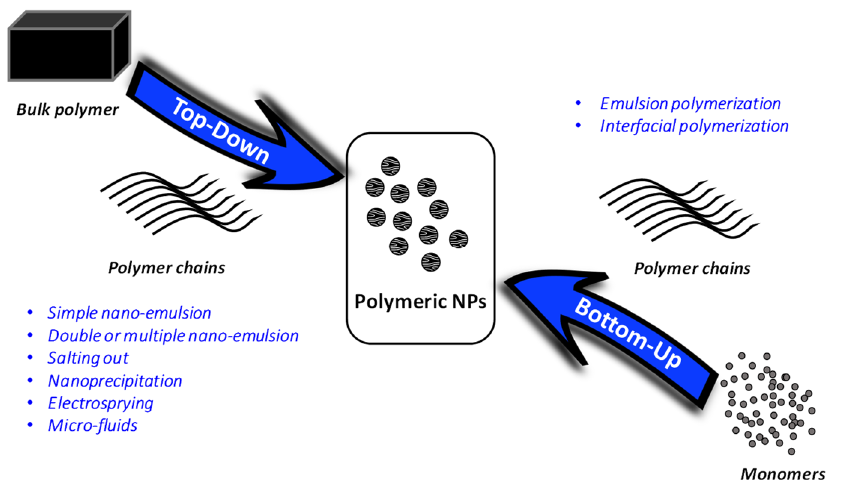
Figure 6. The methods to formulate polymeric NPs are divided into top-down and bottom-up methodologies. Top-down methodologies generate the NPs from preformed polymers, whereas in bottom-up methodologies the polymerization of the monomers is achieved during formulation.